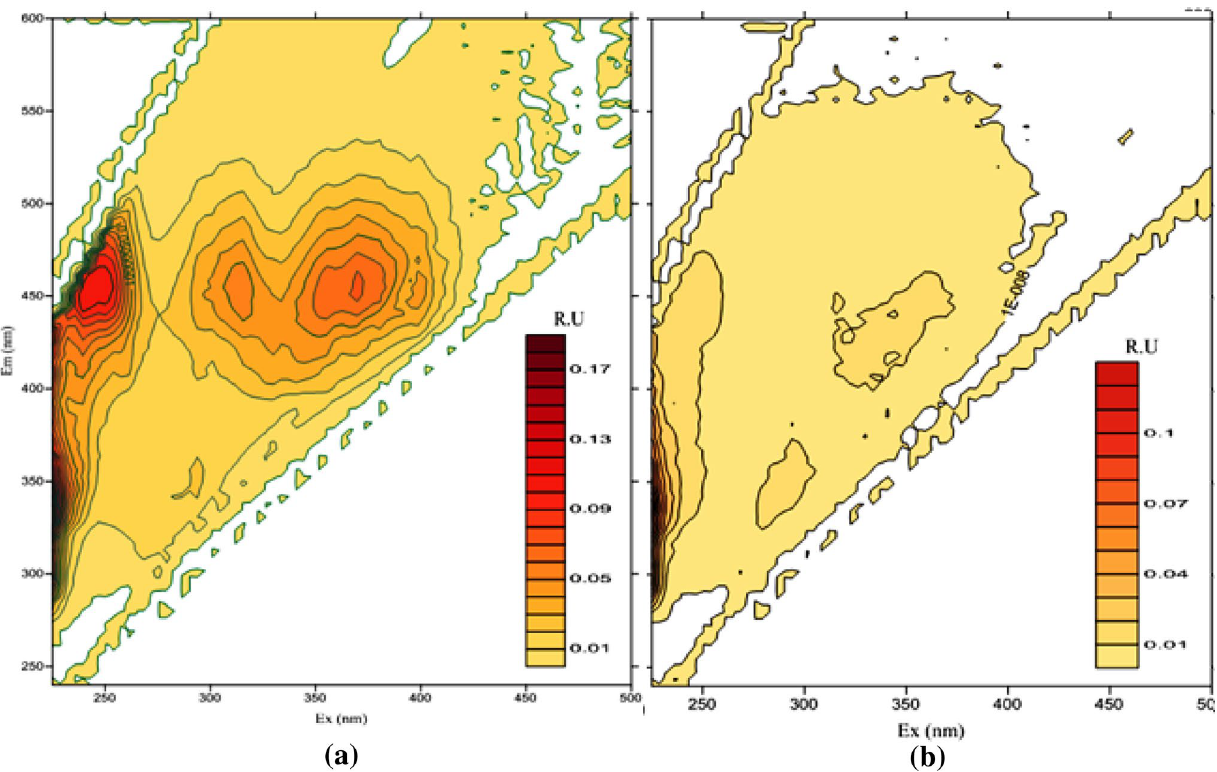
Fig. 8 A representative illustration of three-dimensional excitation emission matrix (3DEEM) fluorescence spectra of wastewater. a Raw waste- water, b at 40 h of irradiation in the presence of Fe 2 O 3 NPs Table 1 Fluorescence properties of Procion blue dye and textile wastewater